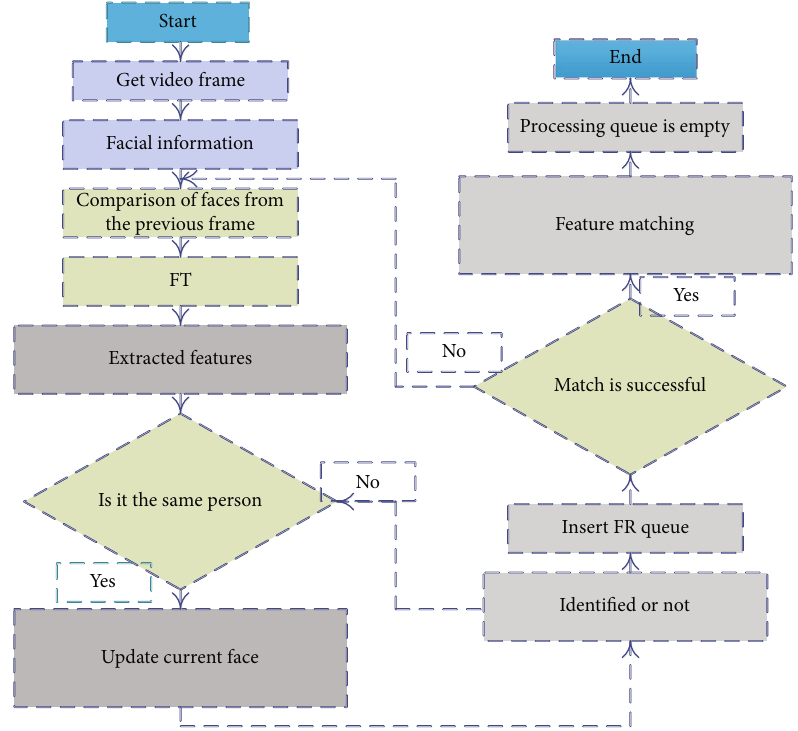
Figure 2: Flow chart of partial di ff erential equation alternately optimized face recognition algorithm. Table 2: Division of concentration in a college Chinese